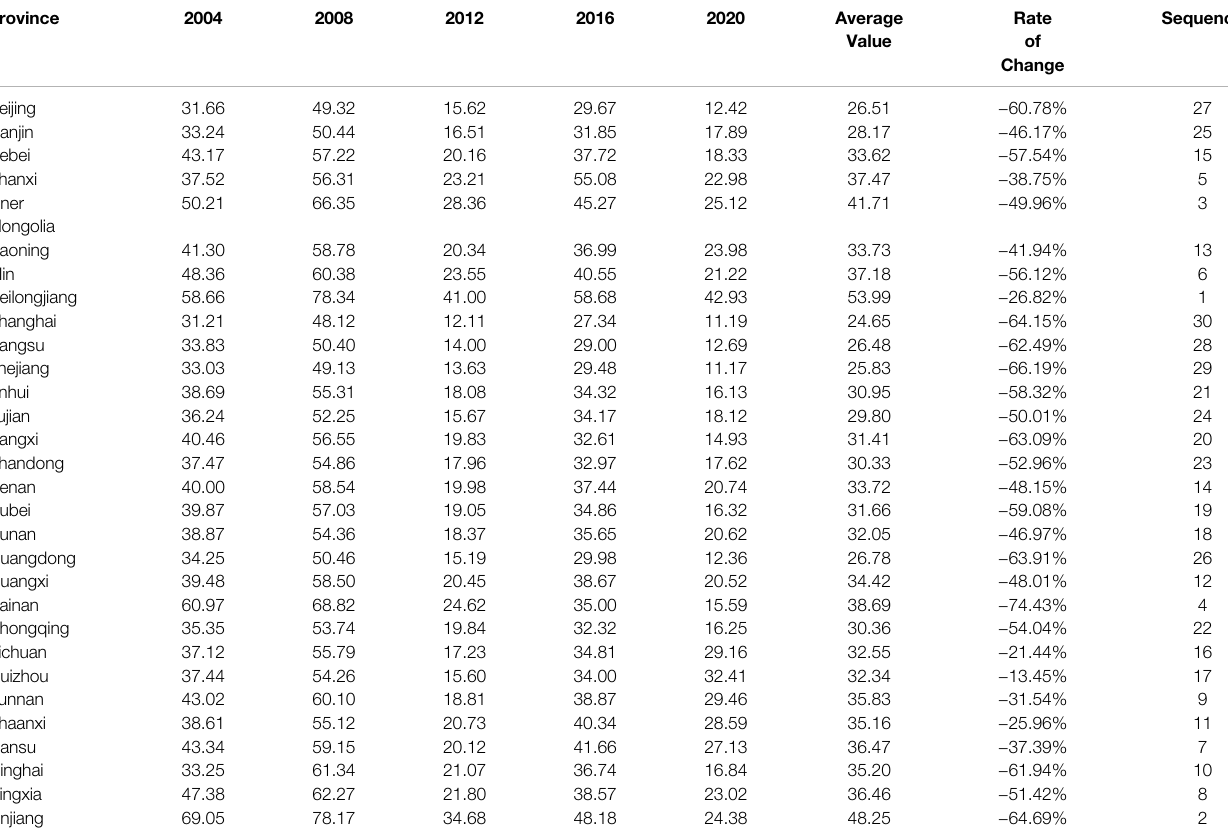
TABLE 1 | Calculation results of resource dependence degree of each province in China from 2004 to 2020.